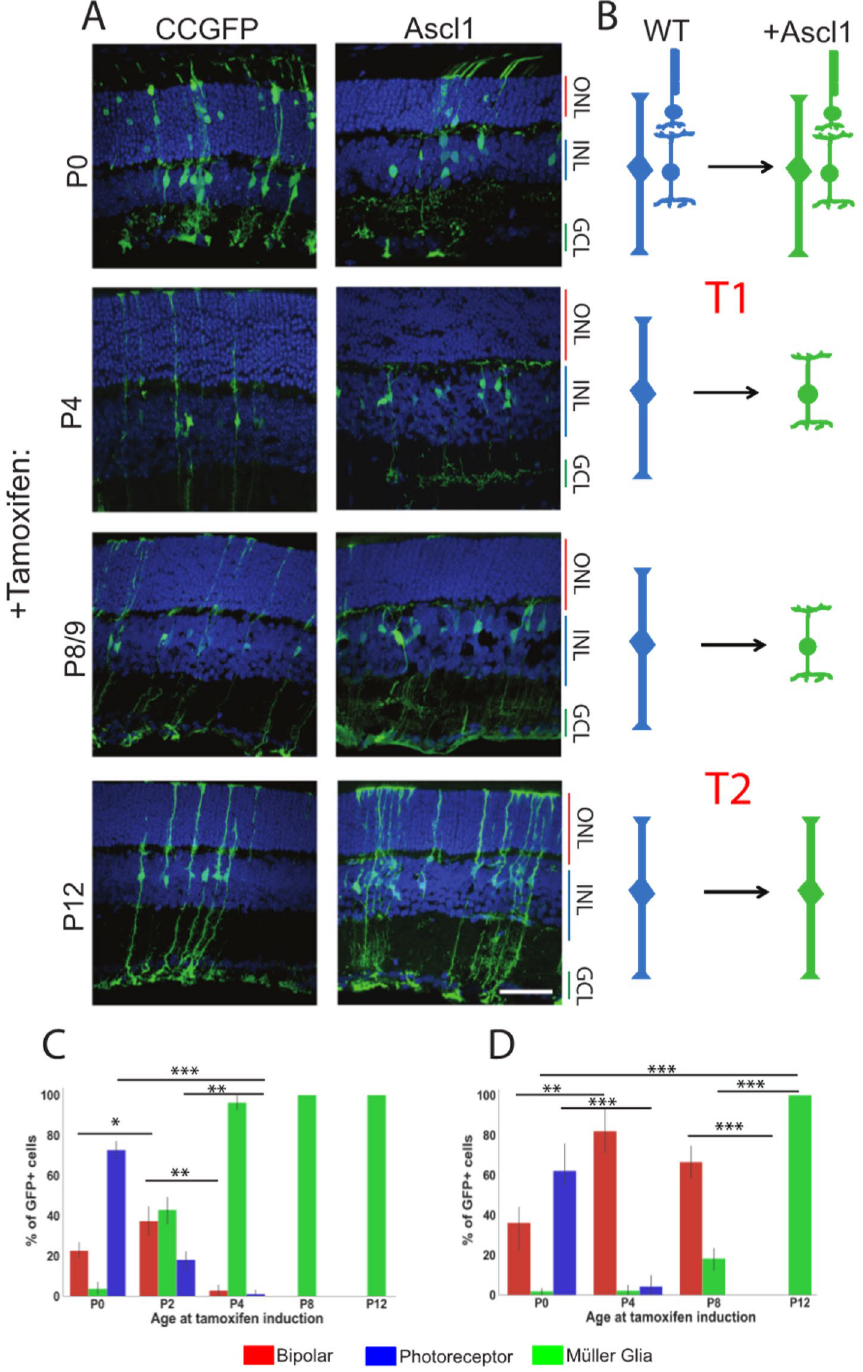
Figure 5. Ascl1 overexpression at young ages is sufficient to generate bipolar neurons. ( A ) Cell tracing of progenitors and MG was induced with CC-GFP or Ascl1-ires-GFP on a Glast promoter at P0, P4, P8/9, and P12. All analyzed at P21. Scale bar 50 um. ( B ) Graphical summary of reprogramming observed with Ascl1. ( C ) Cell counting quantification of GFP cell tracing in ( A ). ( D ) Cell counting quantification of Ascl1 induction tracing in ( A